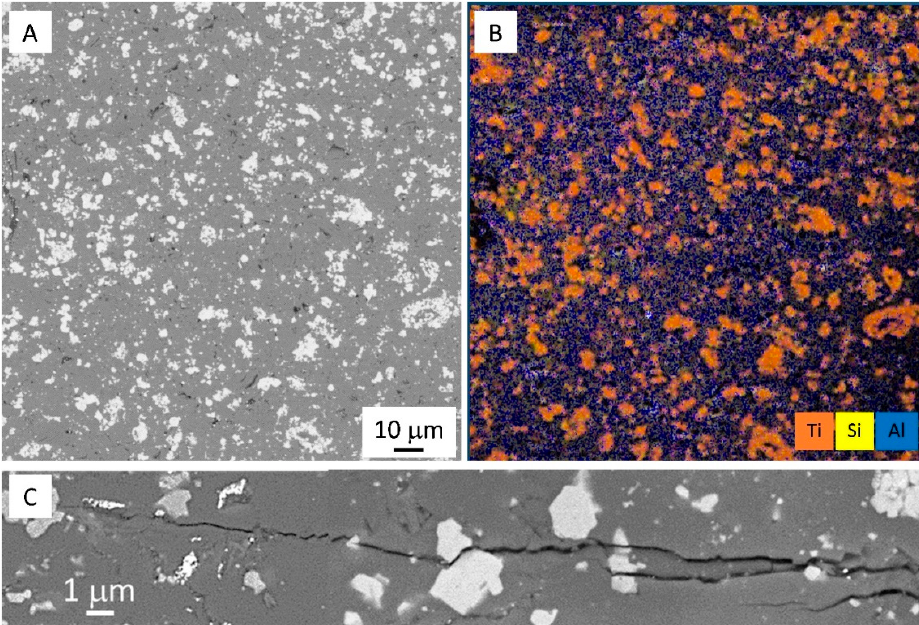
Figure 3. Scanning electron microscope photos of ( A ) polished surface and ( B ) EDS mapping for Ti, Si, and Al elements in the α - β 20T nanocomposites. ( C ) Crack profile formed after indentation on the surface of the α - β 20T nanocomposites. Ceramic matrix: Gray; TiN: Light-gray inclusions. It is also important to note that the mean particle size of ceramic matrix with and without TiN was similar, around 2.1 μ m (Figure 4). Consequently, the presence of TiN did not affect the grain growth of SiAlON matrix.